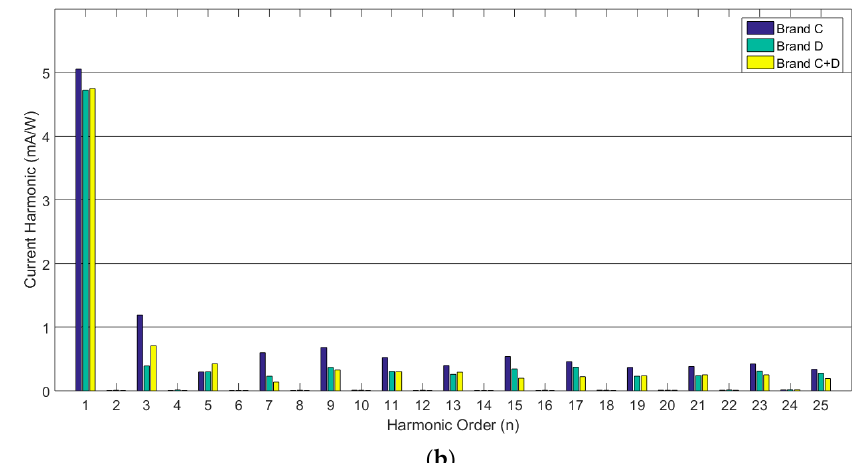
Figure 13. Comparison of harmonic spectrum for case of 8 LED lamps with internal driver among different brands of LED lamp. ( a ) Harmonic spectrum of LED lamp (%f); ( b ) Harmonic spectrum of LED lamp (mA/W).